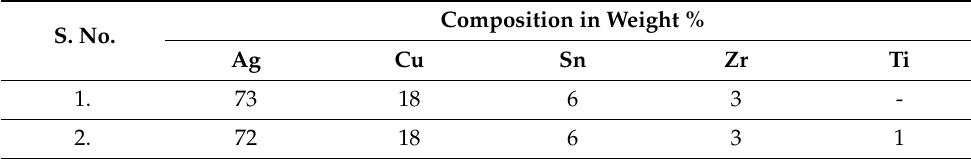
Table 1. Nominal composition of the brazing filler alloy. S.